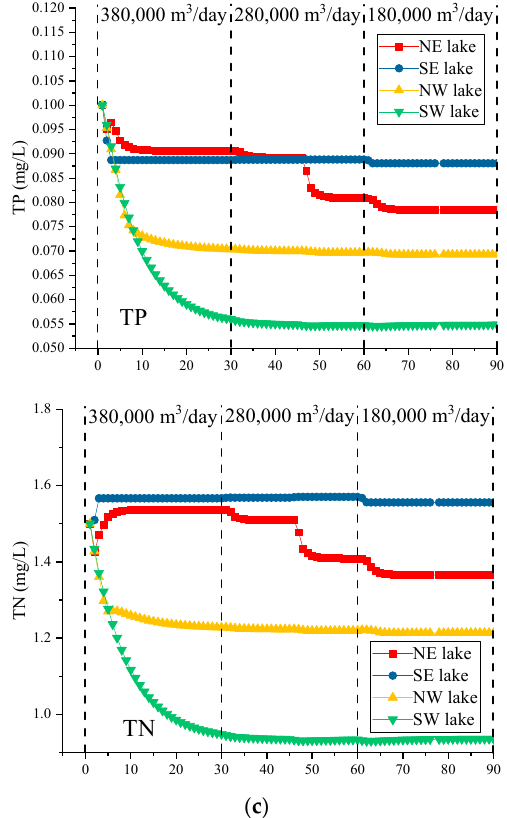
Figure 14. ( a , b ) are the concentration distributions of TP(total phosphorus) and TN(total nitrogen) under southeast wind condition. From left to right, the water diversion schemes for 350,000 m 3 /day, 280,000 m 3 /day and 180,000 m 3 /day respectively; ( c ) shows the changes in water quality under different water diversion schemes for different lake districts in Xuanwu Lake.